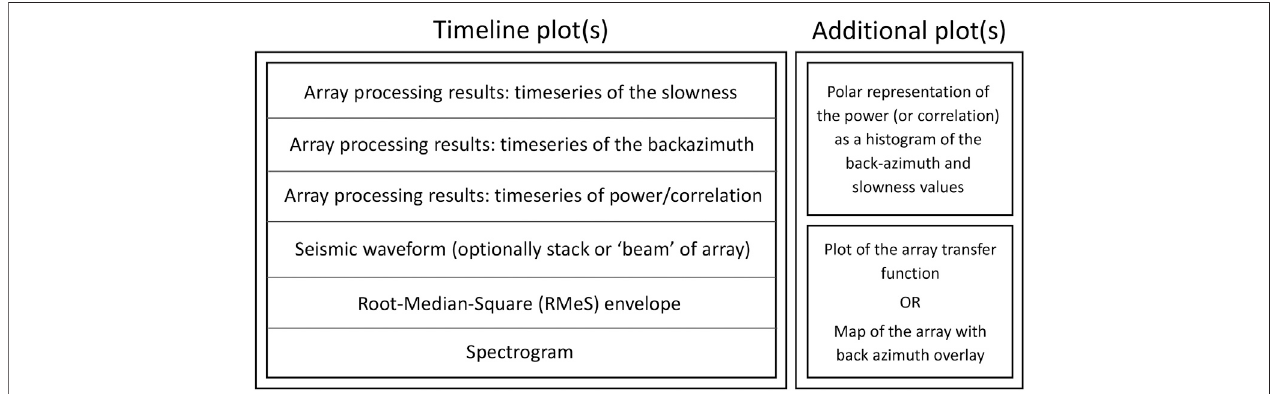
FIGURE 3 | Schematic diagram showing the possible output fi gures that can be produced by RETREAT. The left-hand pane features timeseries of several parameters (slowness, back azimuth, power/correlation, waveform, envelope, spectrogram) plotted on a common timebase. The right-hand plots show a polar representation of the back azimuth and slowness values as well an optional plot of either the Array Response Function or a map of the array.